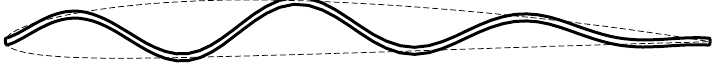
Figure 2. A wavy